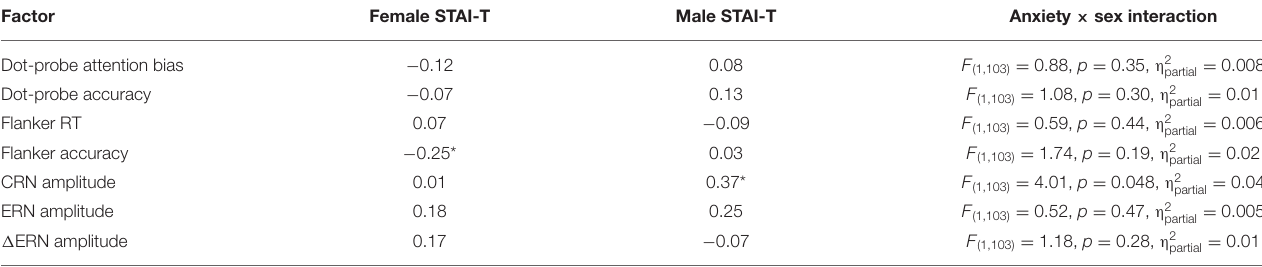
STAI, State Trait Anxiety Inventory; ERN, error-related negativity; CRN, correct-related negativity; 1 ERN, difference score between ERN and CRN. * Indicates bivariate pearson correlation p < 0.05. TABLE 3 | Test of sex differences in the correlations between worry only items and study variables.